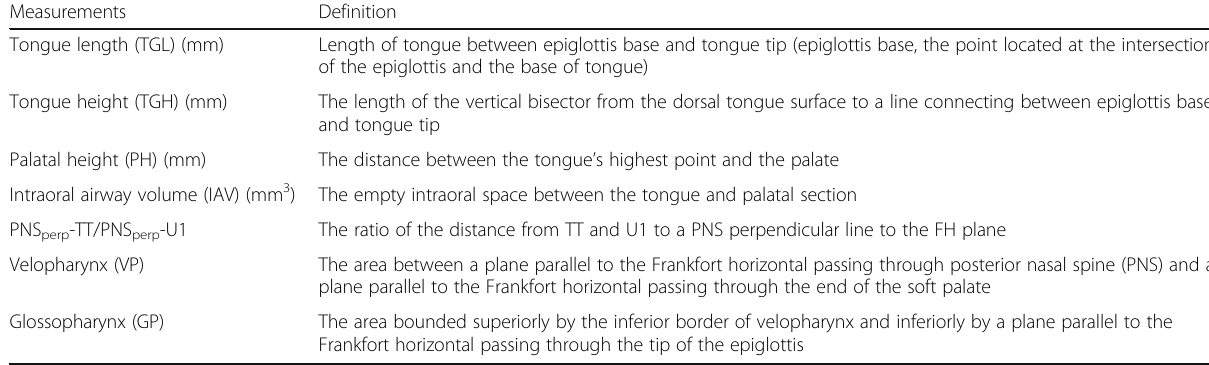
Table 2 Definitions of tongue dimension and position and oropharyngeal airway space measurements used in this study Measurements